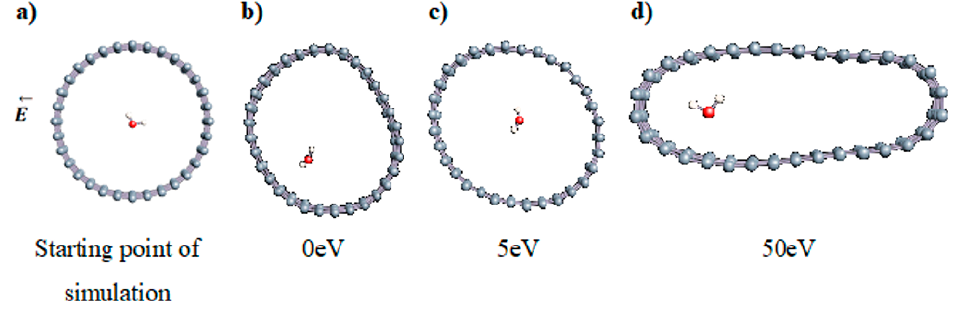
Figure 3. Electrical polarization effect on a water@tube system. ( a ) Initial configuration. ( b – d ) final configuration for E = 0 eV (5 eV and 50 eV, respectively)